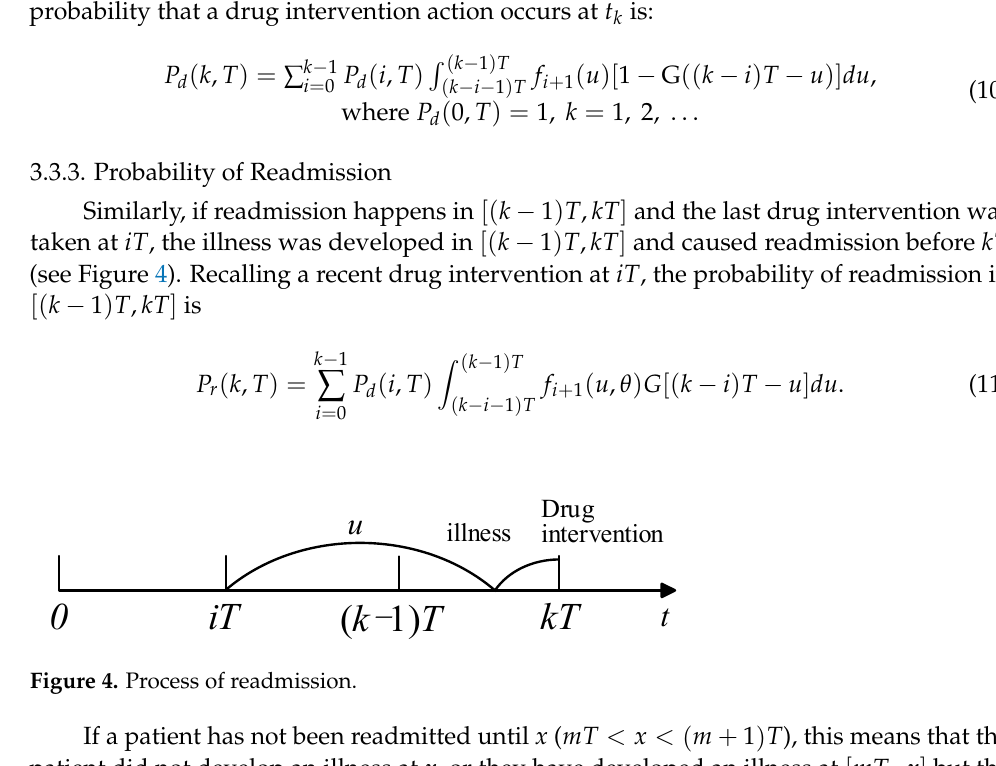
Figure 3. Illustration of drug intervention.